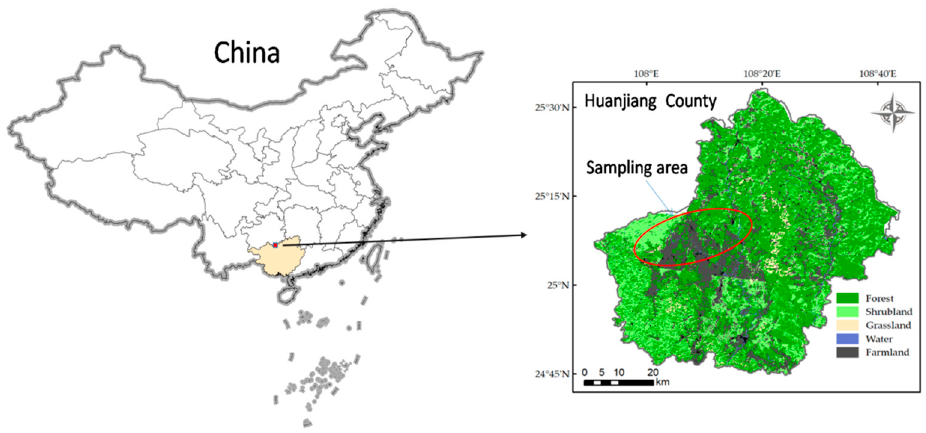
Figure 1. The location of the study area.